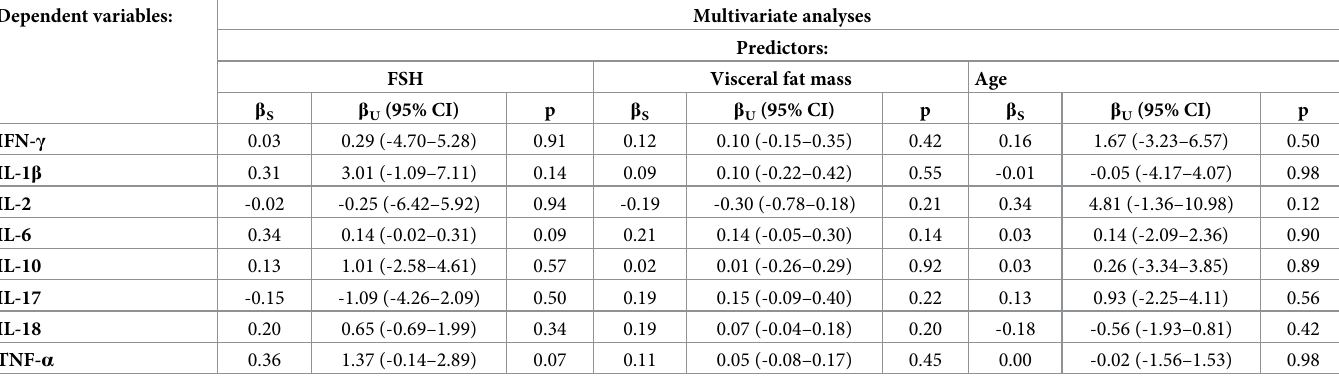
Table 6. Multivariate regression analyses of predictors of plasma cytokine levels. Dependent